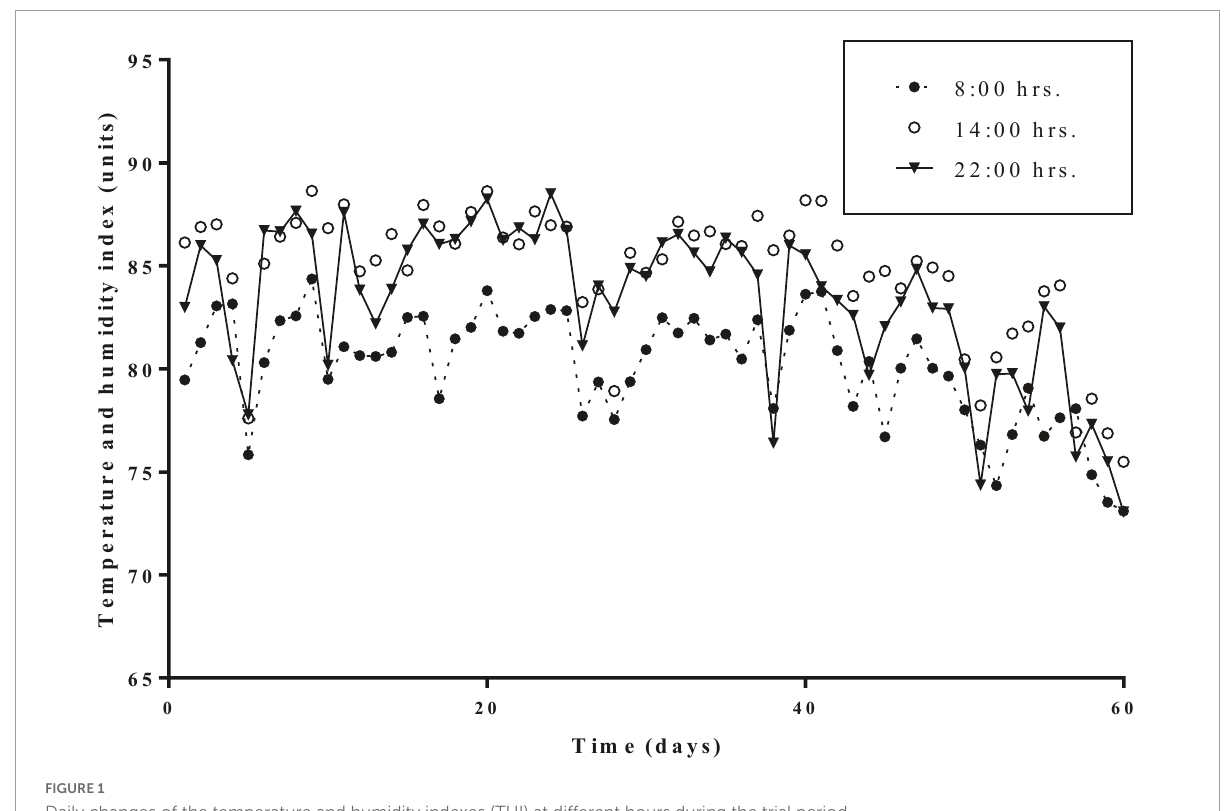
FIGURE1 Daily changes of the temperature and humidity indexes (THI) at different hours during the trial period.